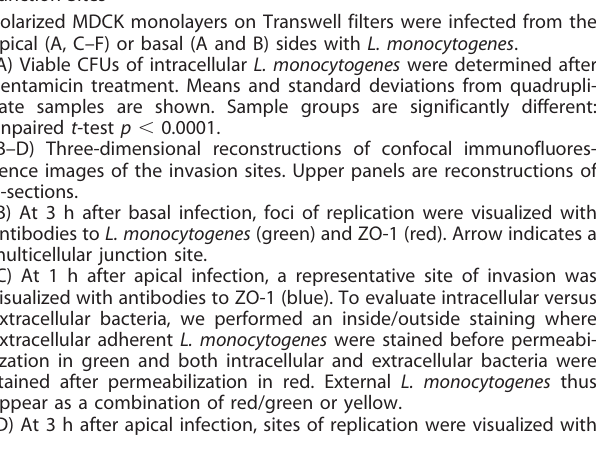
(C) Confocal microscopy visualization of Wt L. monocytogenes adhered to a monolayer stained with antibodies to L. monocytogenes (green) and ZO-1 (red). Bacteria are found only at multicellular junctions and are conspicuously absent elsewhere. (D) A higher magnification area demonstrating concentrated adhesion at a multicellular junction. Scale bars 10 l m. DOI: 10.1371/journal.ppat.0020003.g002